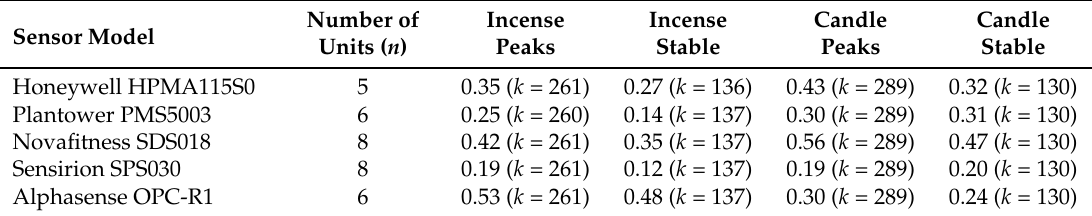
Table 4. Coefficient of variation obtained by the different models of sensors for different sources and different variations of PM sources where n is the number of unit of each model used for the calculation and k is the number of data points